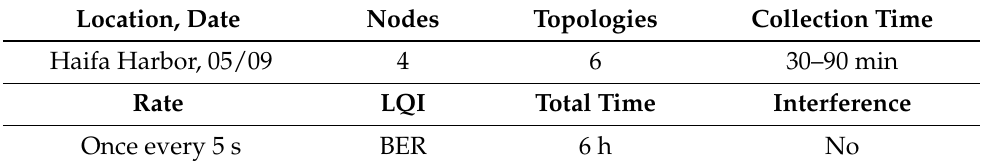
Table 1. Haifa Harbor sea trial details.